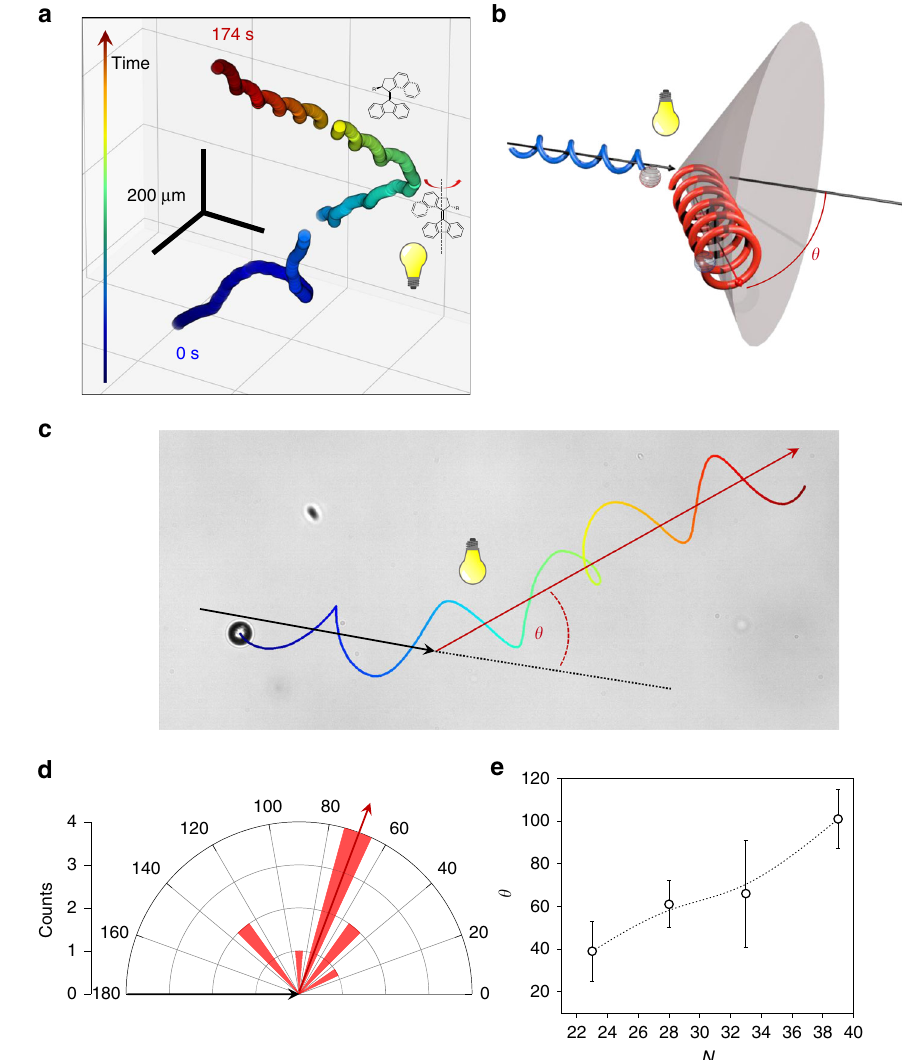
Fig. 4 Reorientation of spiral droplets in response to light. a Three-dimensional motion of a droplet incorporating Me- m motor. Upon strong illumination, the helix inversion operates a sharp reorientation. b A sharp directional change is operated by the spiral droplets upon helix inversion. A chiral droplet follows a right-handed helical trajectory (in blue) and upon strong illumination helix inversion in the droplet inverts the handedness of the trajectory (in red) and modi fi es the direction of droplet motion. The direction of reorientation is characterized by the angle θ . c Two-dimensional trajectory of a droplet that undergoes directional change upon rapid helix inversion. The angle θ is de fi ned as the angle between the helical axis of motion before (black arrow) and after illumination (red arrow). d Measured reorientation angle θ for N = 32. These angle values are meaningful only between 0 and 180, which means that a cone of deterministic reorientation is associated to each reorientation angle θ . e , Dependence of θ from the chirality con fi nement ratio N . The angle of photo-stimulated re-direction increases with N . The error bars indicate standard deviation, the dashed line is a guide for the